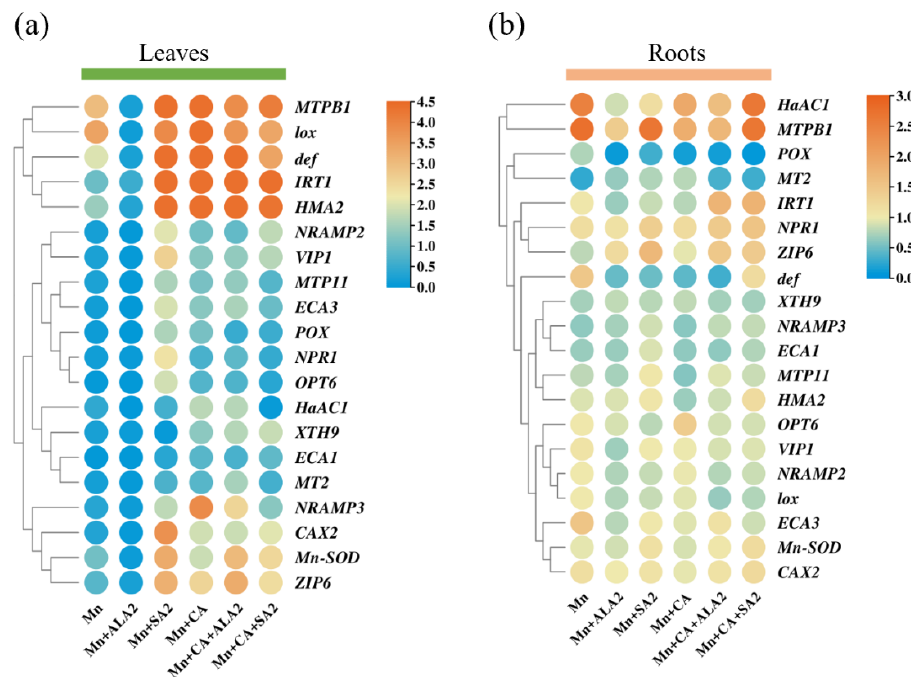
Figure 6. Heatmap representation of the effects of 5-aminolevulinic acid or salicylic acid (ALA/SA) combined with citric acid (CA) on tolerance-related gene expression patterns in the leaves ( a ) and roots ( b ) of manganese (Mn)-treated sunflower plants. Mn, plants exposed to 0.8 g kg − 1 Mn for 7 days; Mn + CA, plants treated with CA for 7 days after Mn treatment; Mn + ALA2/SA2, plants treated with 20/100 mg L − 1 ALA/SA for one week after Mn treatment; Mn + CA + ALA2/SA2, plants treated with 20/100 mg L − 1 ALA/SA for one week after CA treatment. The relative expression levels are calculated with the 2 −ΔΔ Ct method compared with that of EF-1 α with three replicates. Every control of the expression level was normalized as “1” and log 2 fold change between two treatments is used to present expression changes.